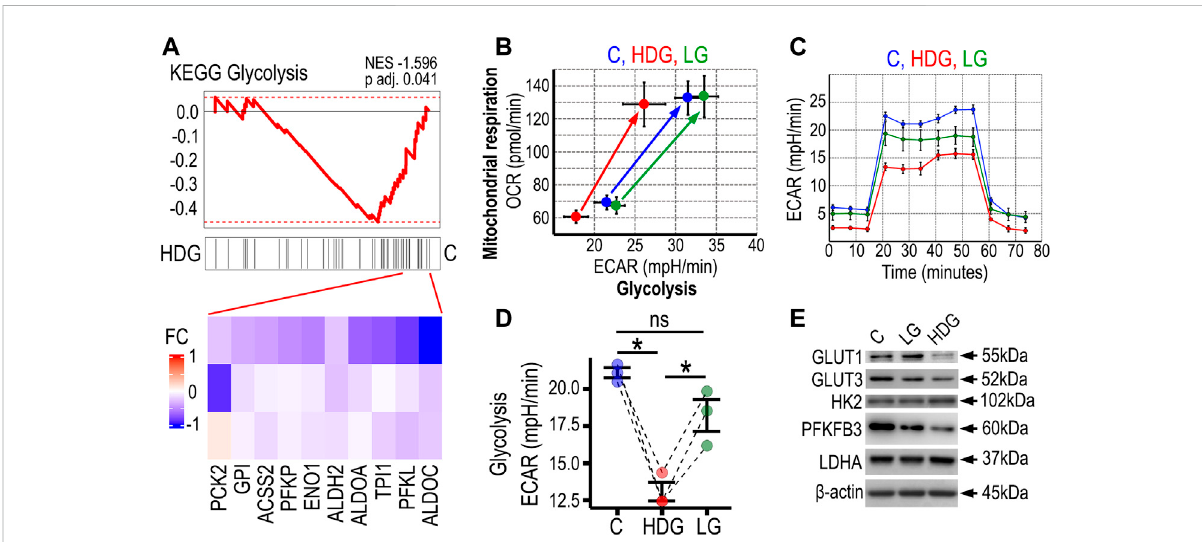
FIGURE 3 High glucose-induced premature senescent HRMECs exhibit diminished glycolysis. (A) Gene Set Enrichment Analysis for Glycolysis gene signature. Transcriptome data from bulk RNA sequencing of three biological replicates of HRMECs cultured with 25 mM D-glucose vs. the 5 mM control at 4 weeks of culture. Gene signature from KEGG Glycolysis was used for the gene set enrichment analysis (GSEA). Heatmaps below depict the leading edges for transcripts responsible for major differences. NES: Normalized Enrichment Score. p adj: adjusted p value. (B) Energy phenotype plot from Seahorse XFe96 analyzer depicting assessment of glycolysis as extracellular acidi fi cation rate (ECAR) and mitochondrial respiration as oxygen consumption rate (OCR) at baseline and stressed phenotypes. (C) Glycolysis stress assay to characterize glycolysis in HRMECs under different culture conditions. Injections in the assay were glucose at 20 min, oligomycin at 40 min, and 2-DG at 60 min. (D) Statistical comparison of basal glycolysis measures using Seahorse Glycolysis stress assay in three biological replicates. (E) Western blot analysis to compare expression ofglycolysis-relatedproteins. β -actin wasusedas theloading control.* p < 0.05, ns: not signi fi cant. One-way ANOVA,withTukey ’ spost- hoc analysis was used. C, control in blue; LG in green, 25 mM (+L-glucose); HDG in red, 25 mM